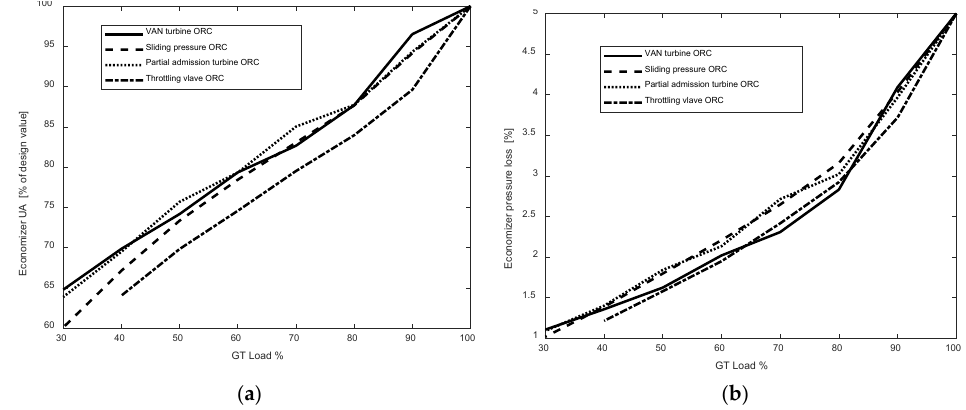
Figure 9. Economizer off-design characteristics: ( a ) heat transfer coefficient; ( b ) pressure loss.